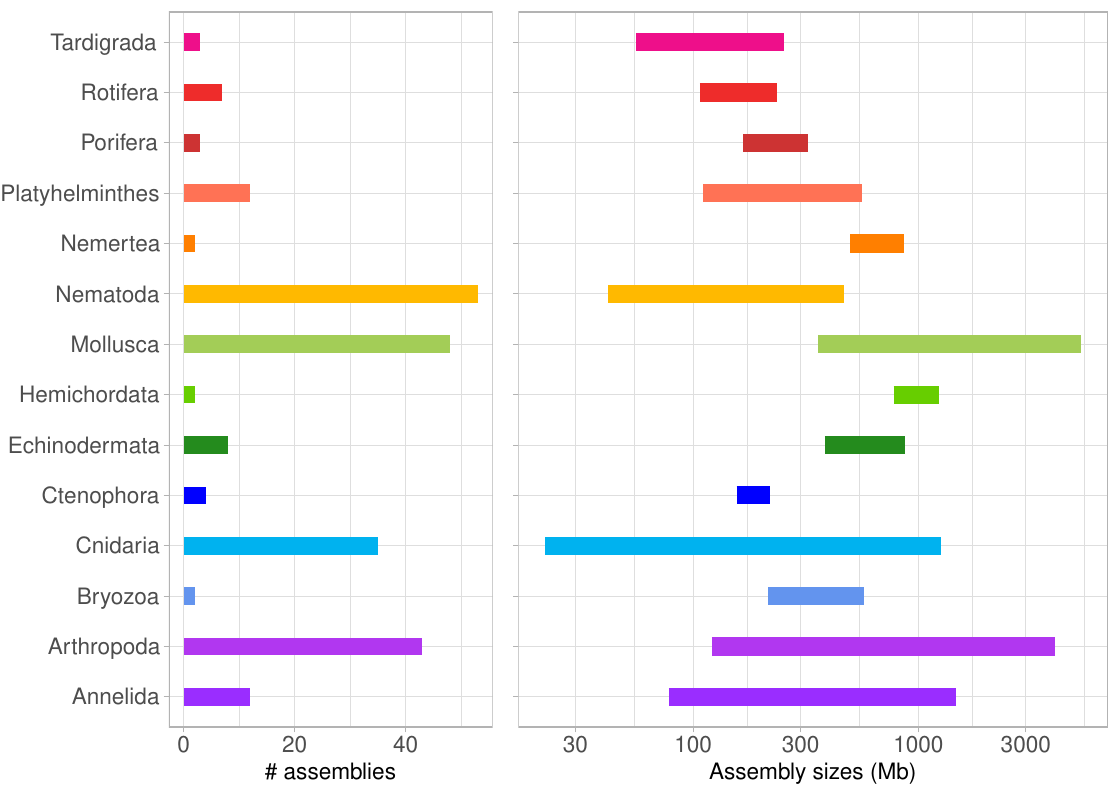
Figure 4 – Assembly sizes. The left graph shows the number of assemblies included for each phylum and the right part shows the corresponding assembly-size